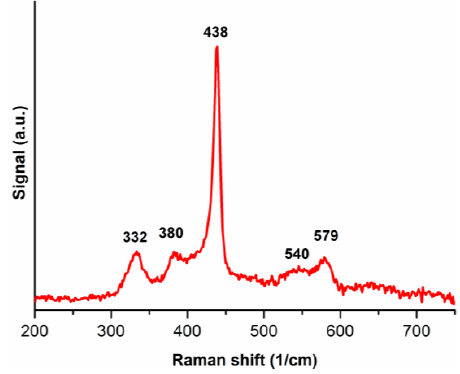
Figure 4. Raman spectrum of ZnO nanostructures.